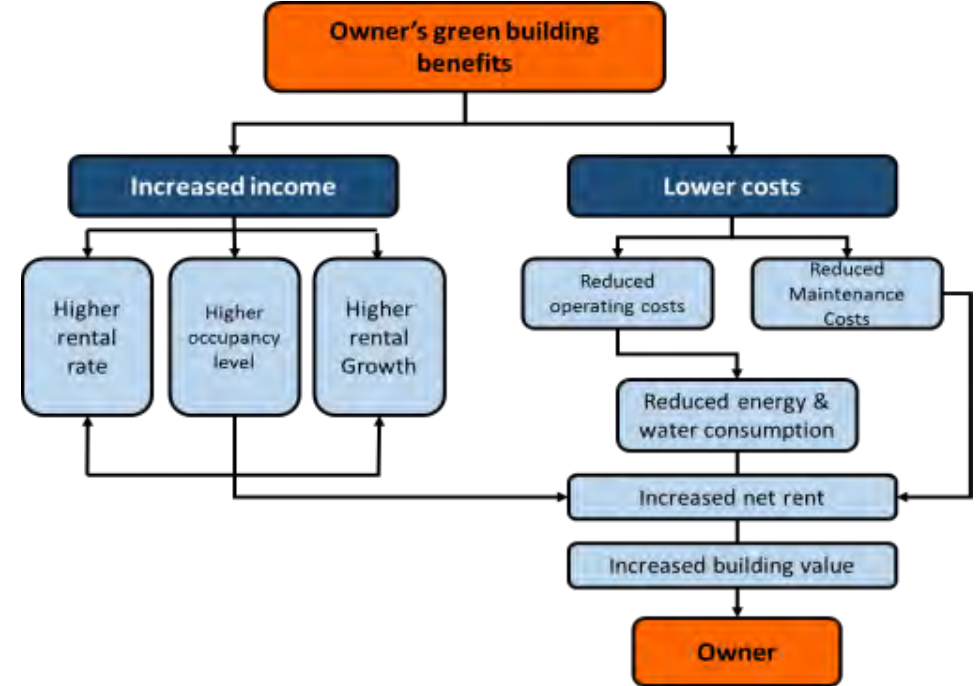
Figure 6. Owner’s green building